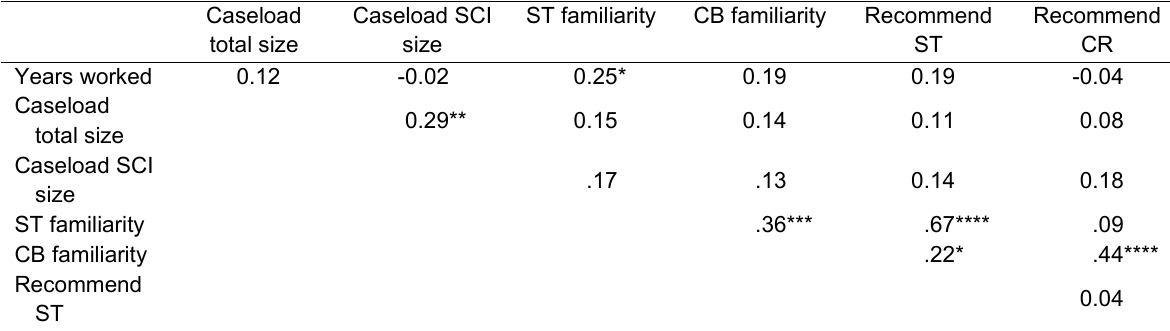
Spearman Correlation Coefficients and Significance for Case Managers’ Work Experience Factors and Likelihood of Recommending Service Delivery Options